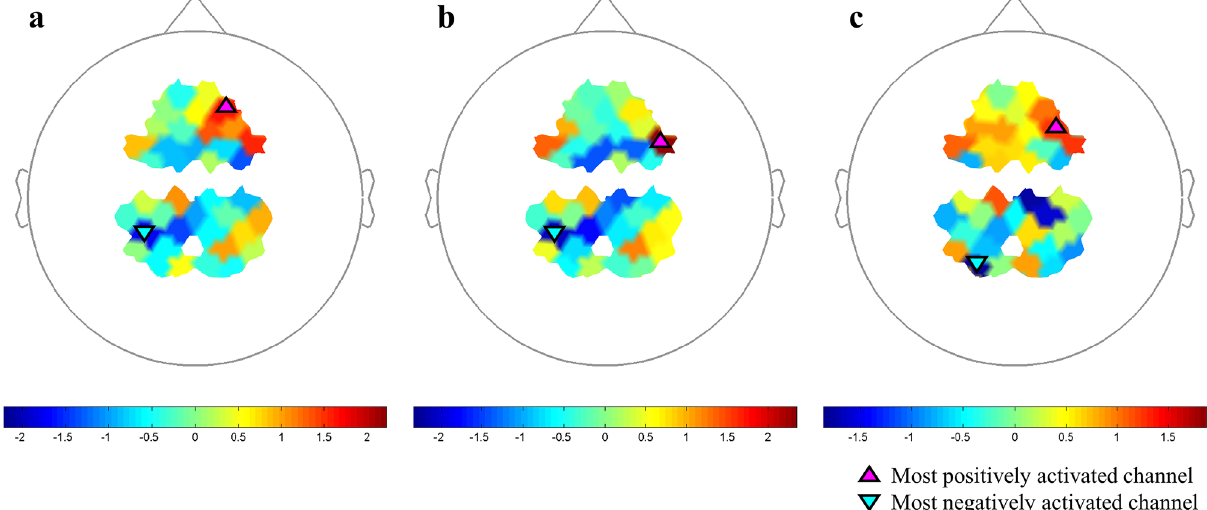
Figure 7. Cortical regions most activated during pointing in VPAT-10° ( a ), VPAT-20° ( b ) and post-VPAT ( c ) by contrast to the pre-VPAT pointing. The most significantly activated areas on the t-maps are marked with black-lined triangle symbols: pink-colored triangles for most positively activated areas and sky-blue-colored inverted triangles for most negatively activated areas. On each SPM t-map, each colored area corresponds to a single channel. Redder color means more activation during each phase in contrast to Pre-VPAT phase, and vice versa. VPAT, virtual prism adaptation